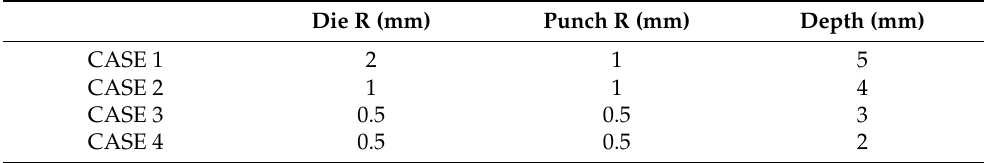
Figure 1. Finite element analysis model of ( a ) drawing process and ( b ) electromagnetic forming (EMF). Table 1. Design parameters for